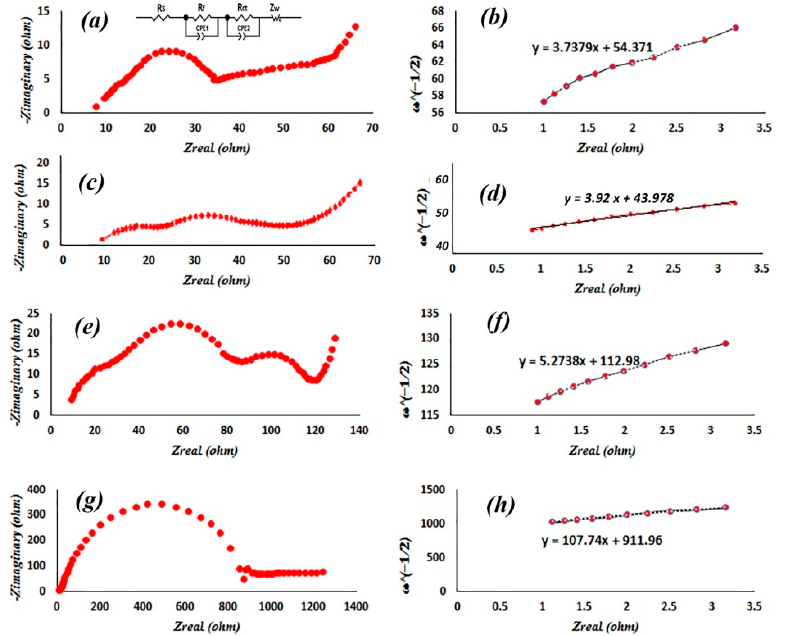
Figure 6. EIS spectra of TiNb 2 O 7 and Ti 2 Nb 10 O 29 annealed under different atmospheres ( a , e ) oxygen atmosphere, ( c , g ) argon atmosphere, and equivalent circuit for fitting experimental data, ( b , d , f , h ) the relationship between Z ′ and the square root of frequency ( ω -1/2) in the low-frequency region for TiNb 2 O 7 and Ti 2 Nb 10 O 29 .